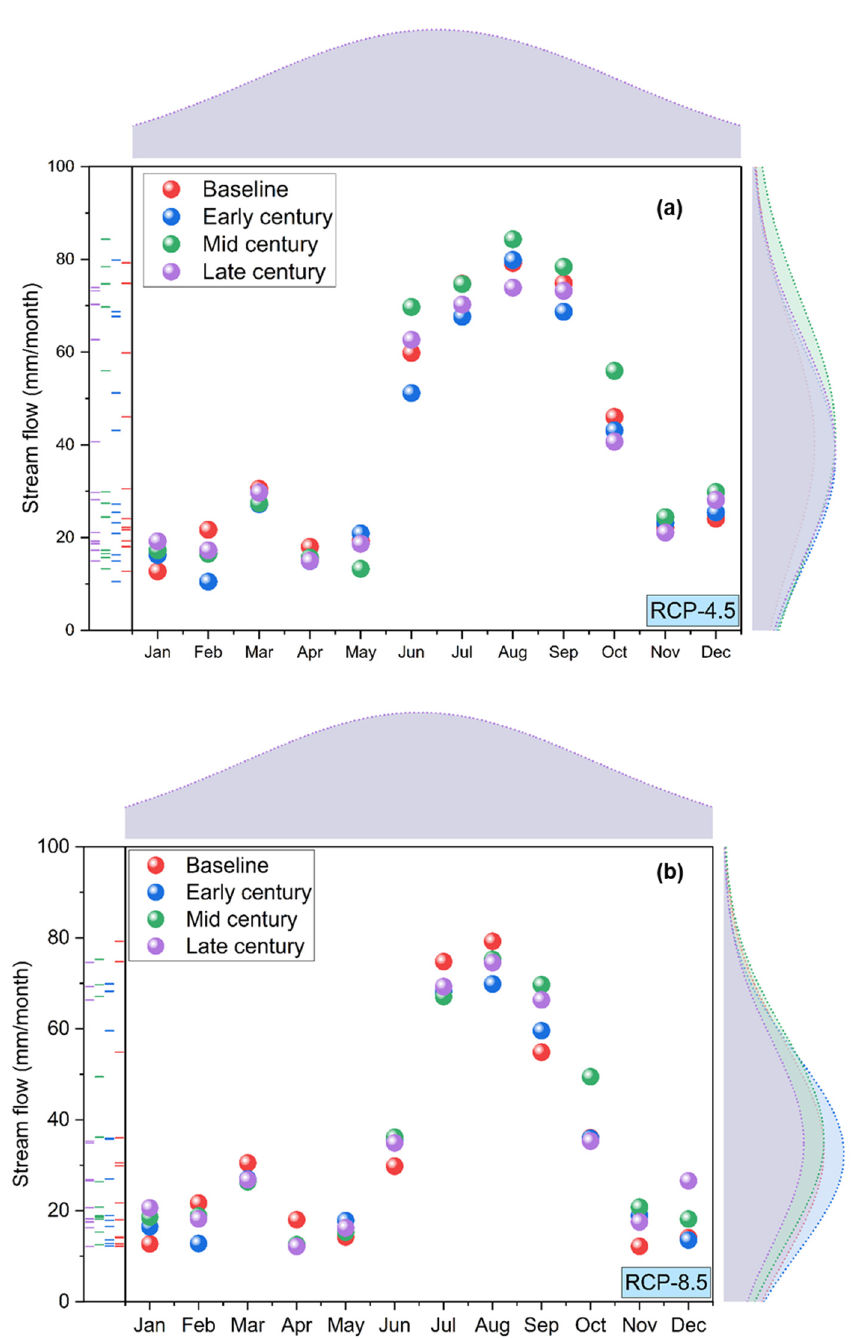
Figure 11. Monthly changes in stream flows for baseline to late century with their marginal distribution curves in the SRB under ( a ) RCP-4.5 and ( b ) RCP-8.5.